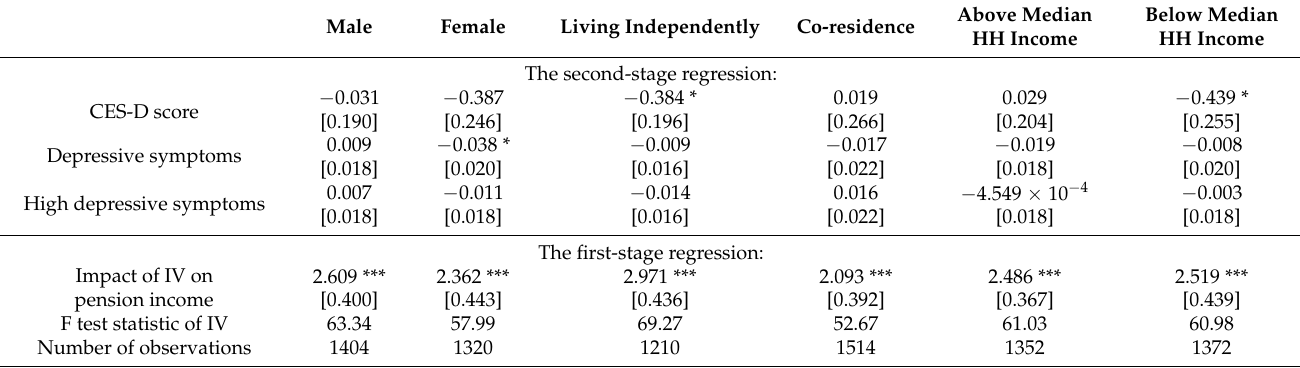
Table 7. Heterogeneous effects of the NRSPI pensions on mental health outcomes. Male Female Living Independently Co-residence